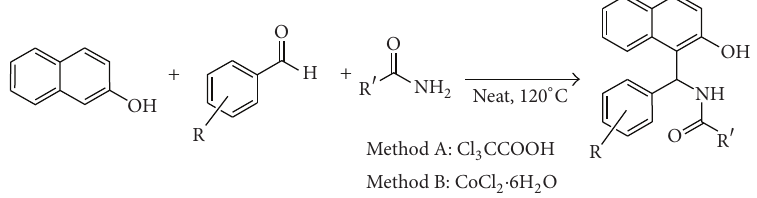
S 1: Synthesis of 1-amidoalkyl